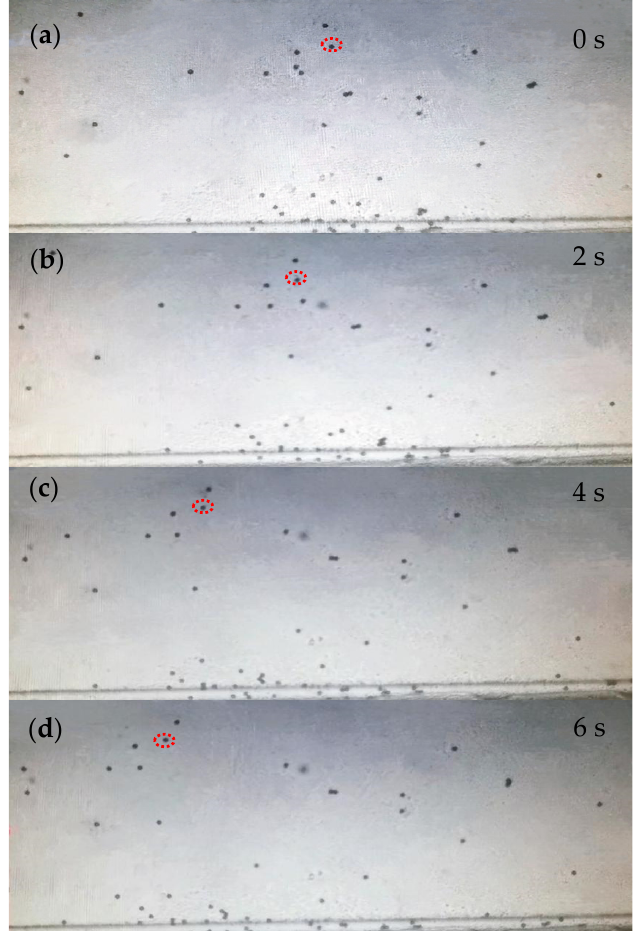
Figure 9. Images showing the pumping behavior at 12.8 kHz by indicating the movement of polystyrene beads in acoustic micropump at different time frames when ( a ) t = 0 s, ( b ) t = 2 s, ( c ) t = 4 s, ( d ) t = 6 s.